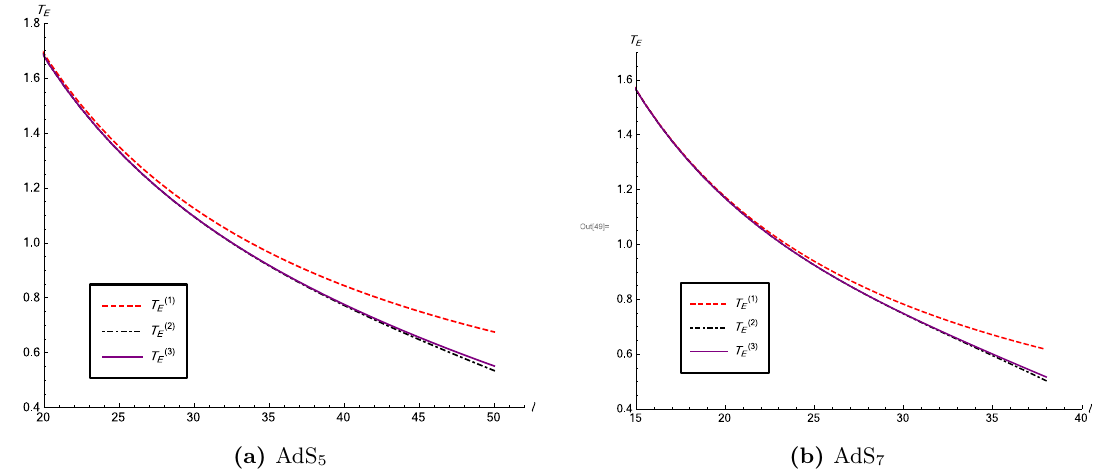
Figure 3. The entanglement temperature with and without higher order corrections of AdS plane wave for d = 4 and 6 , plot drawn for z I = 100